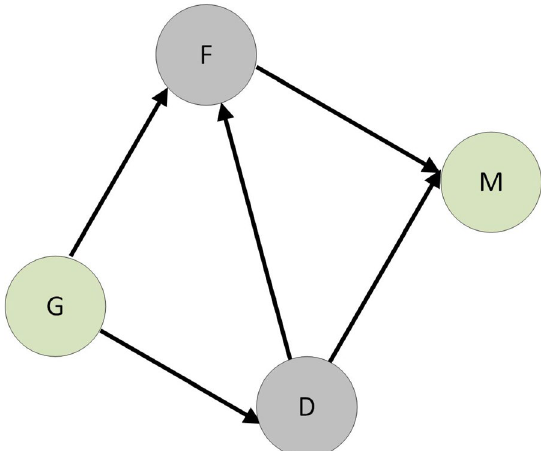
Fig. 5 The trusted graph for the graph theory